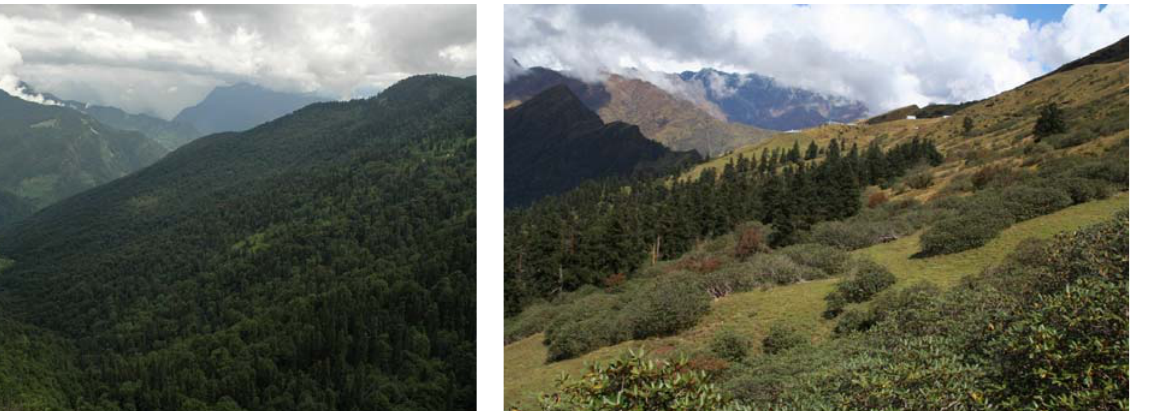
Image 6. Striaight Swift, Parnara guttatus (upper)